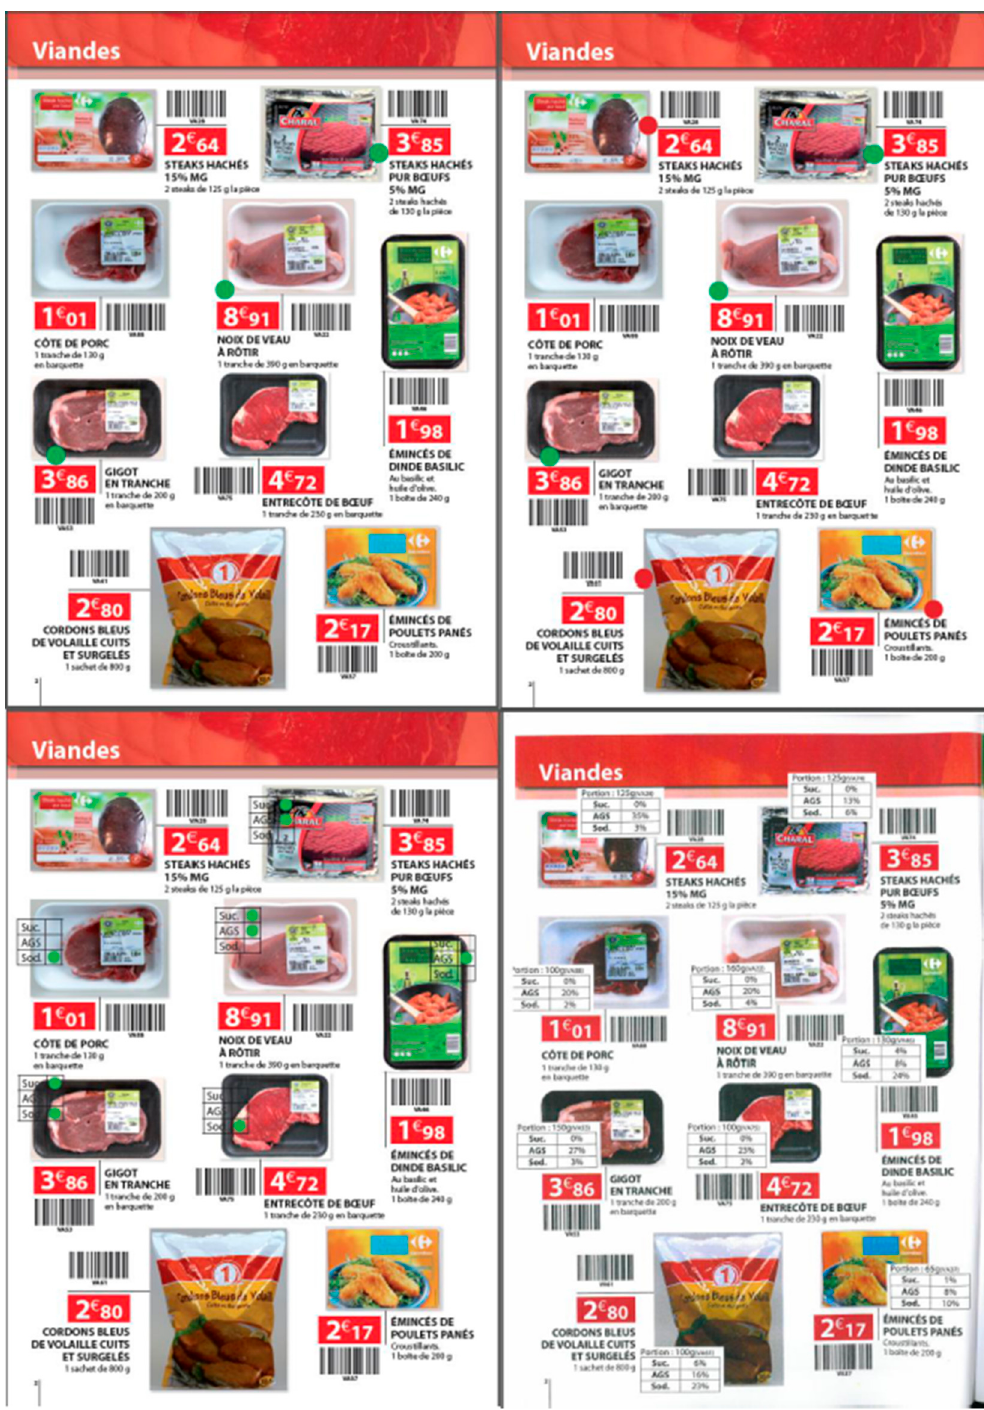
Figure A16. Food catalogue with labels – Example of the meat category with the Food-Directive, Within-Category, Recommended (F-W-R) logo system at the top left, Food-Directive, Within-Category, Recommended and Warned (F-W-R&W) at the top right, Diet-Directive, Across-Category, Recommended (D-A-R) at the bottom left and Reference Intake (RI) at the bottom right.